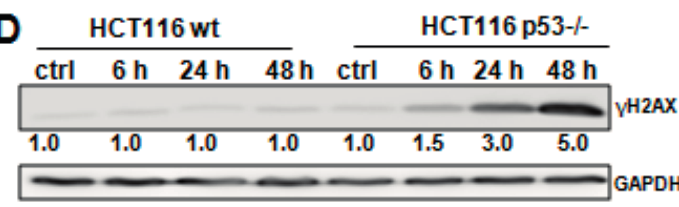
Figure 3. Apoptosis induction after crocin treatment. ( A ) Annexin-PI measurements of untreated cells (Ctrl) and two cell types, HCT116 wild-type (wt) and HCT116 p53 − / − , treated with 10 mM crocin for 6, 24, and 48 h. The profile represents Annexin-V-FITC staining on the x -axis and PI on the y -axis; ( B ) Quantitative analysis of percentage gated for viable, necrotic, early apoptotic, and late apoptotic HCT116 wild-type (wt) and HCT116 p53 − / − cells treated with 10 mM crocin for 6, 24, and 48 h; ( C ) Lysates prepared from two cell types, HCT116 wild-type (wt) and HCT116 p53 − / − , untreated (Ctrl) or treated with 10 mM crocin for 6, 24, and 48 h, were analyzed by anti-caspase3, anti-PARP, and anti-GAPDH Western blotting. GAPDH served as the internal control for equal loading; and ( D ) Lysates prepared from two cell types, HCT116 wild-type (wt) and HCT116 p53 − / − , untreated (Ctrl) or treated with 10 mM crocin for 6, 24, and 48 h were analyzed by anti- γ H2AX, and anti-GAPDH Western blotting. GAPDH served as the internal control for equal loading. The ratios represent protein alterations compared to the